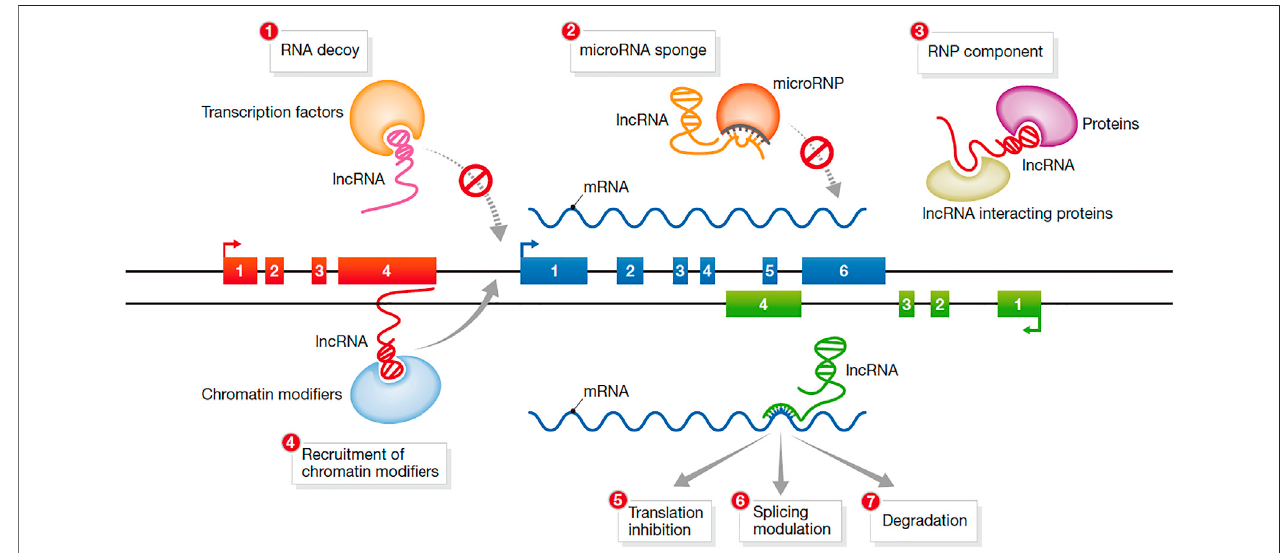
FIGURE 3 | Mechanisms of action of lncRNAs (Hu et al.,